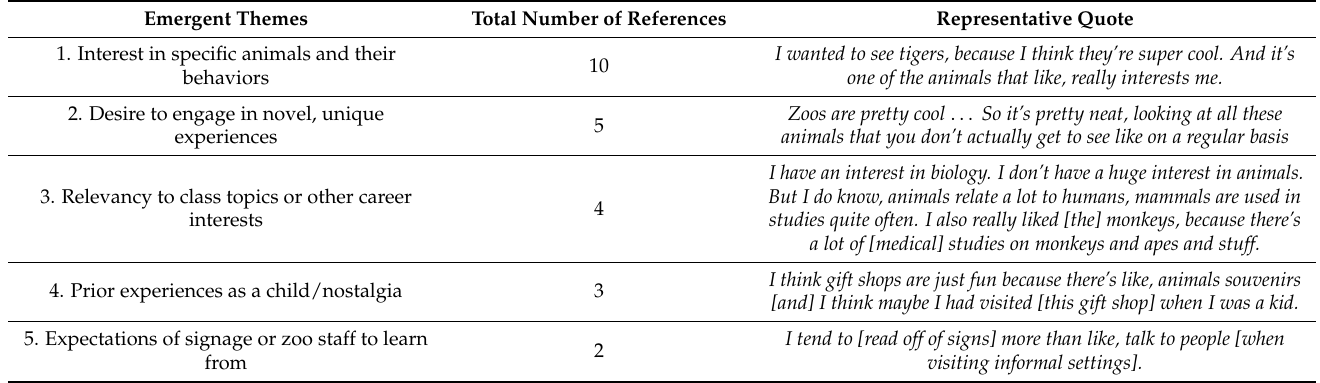
Table 4. Emerging themes from follow-up think-aloud interviews asking why students set their learning and activity goals, based on a subset of introductory biology students who participated in the zoo trip ( n = 10). Participant’s responses could be dual-coded into multiple